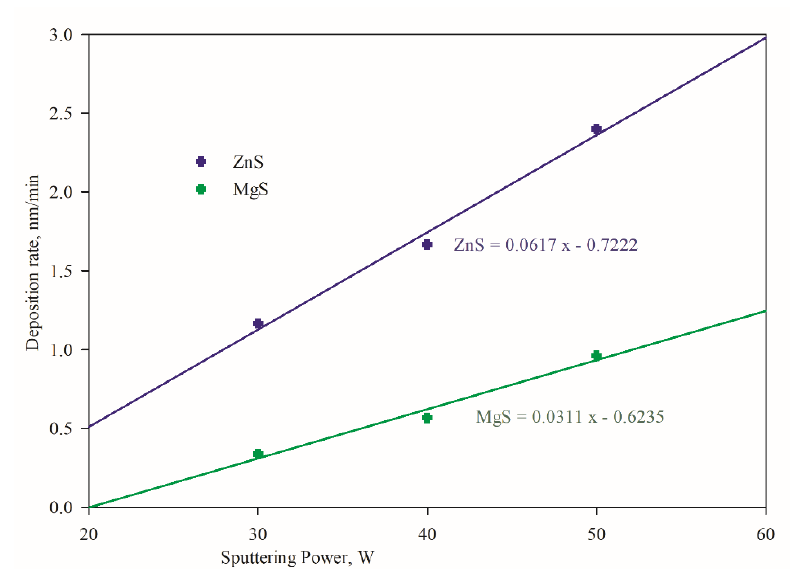
Figure 2. Effect of sputtering power on the film deposition rate. Figure 2. E ff ect of sputtering power on the film deposition rate.